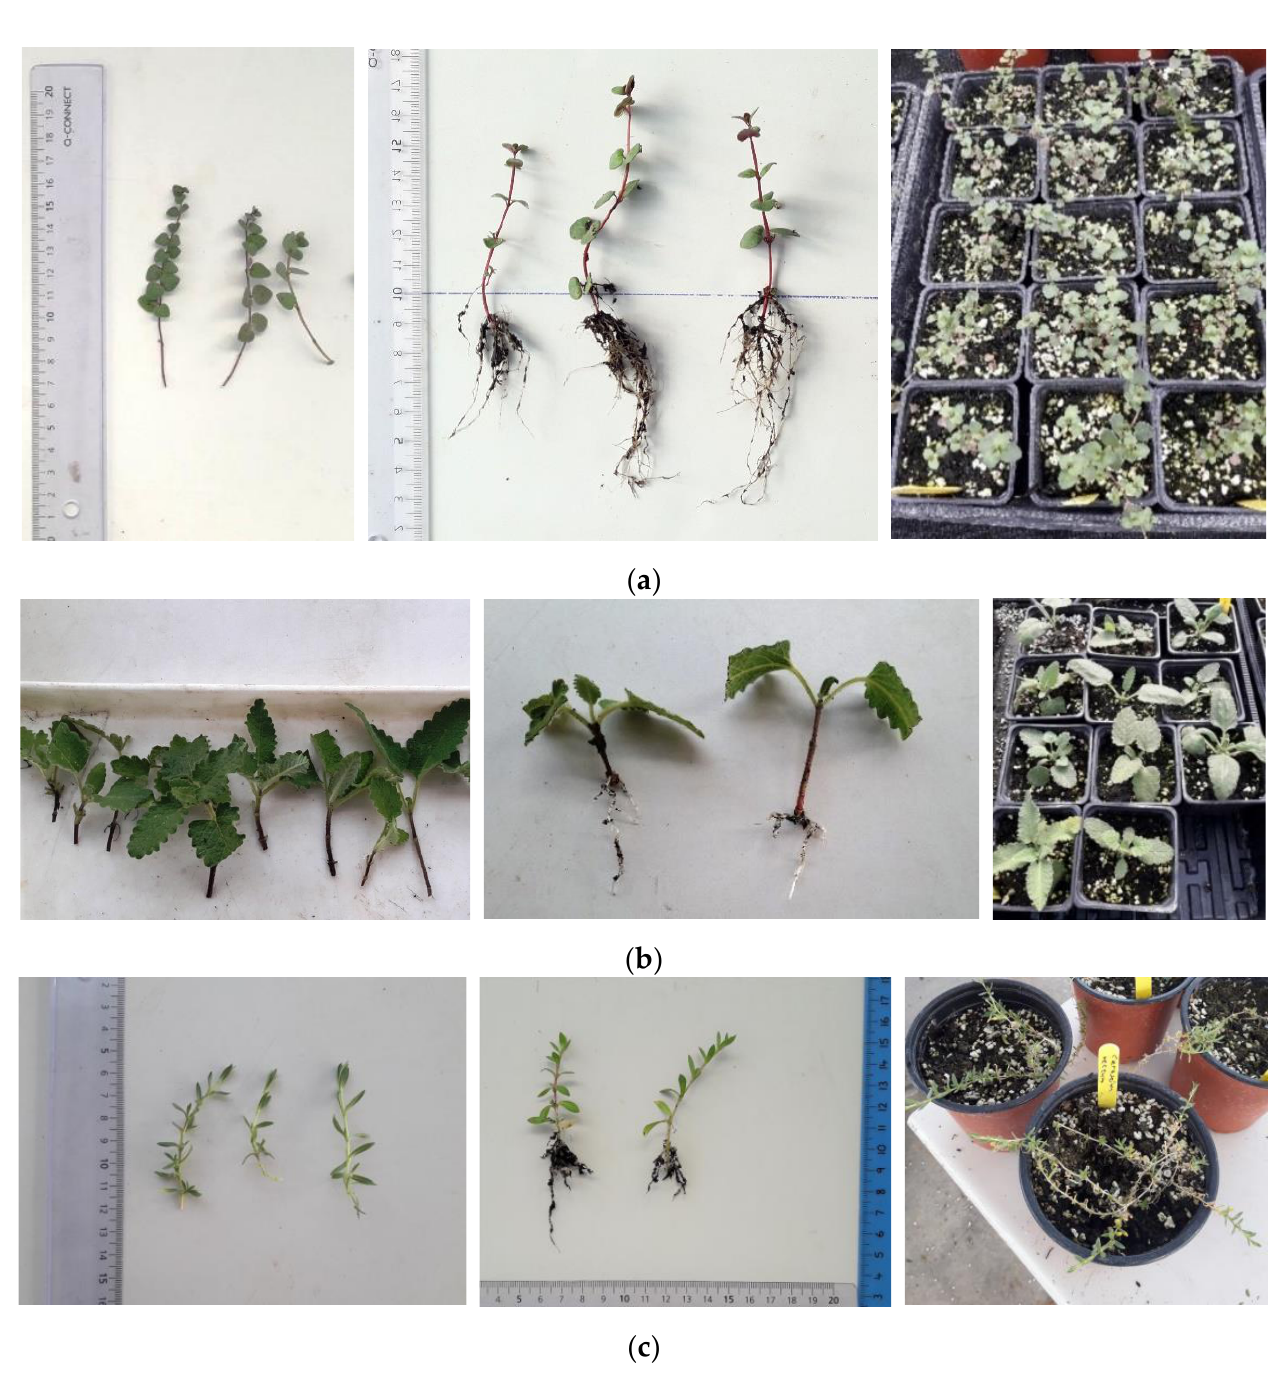
Figure 5. Representative photos of asexual propagation via cuttings (cutting preparation from mother plants, rooted cuttings, transplanted young individuals) of wild-growing plants in different conservation priority categories. ( a ) Priority A1 taxon Thymus oehmianus (Lamiaceae) with accession number 19,365; ( b ) Priority B4 taxon Betonica scardica with accession number 19,451; ( c ) Priority C3 taxon Cerastium rectum subsp. petricola with accession number 19,493.